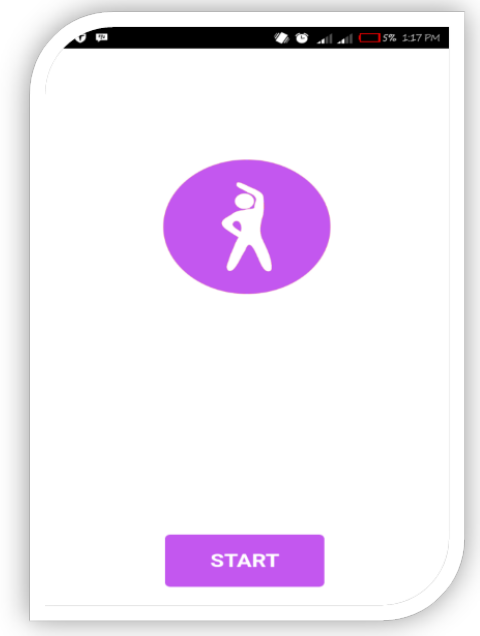
Figure 2. User Interface skin of the TBMT app.